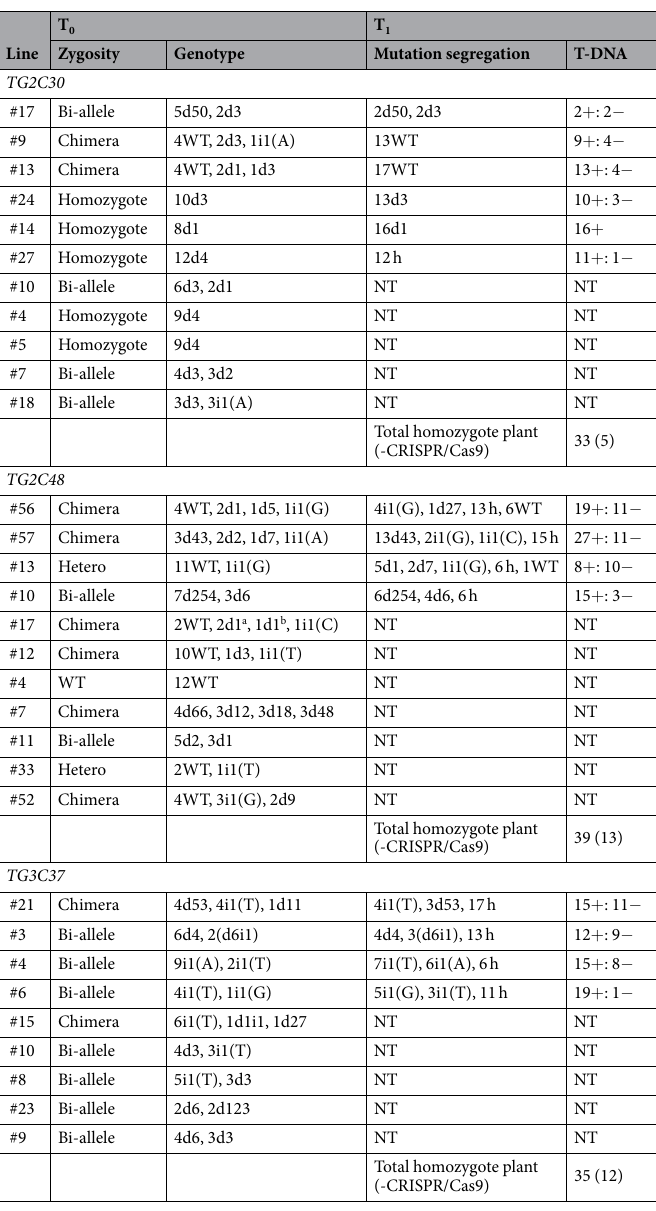
Table 1. CRISPR/Cas9-induced mutations in target genes. The zygosities, such as homozygote, bi-allele and heterozygote, were estimated on T 0 plant. WT, wild-type sequence with no mutation detected. “d” and “i” mean deletion and insertion, respectively. (A,T,G,C) after “i” indicated the inserted base pair. “il (T) means “T” was inserted on target site. In T 0 generation, “d#” or “i#” is # of base pair were deleted or were inserted on target site. Numbers before “d” or “i” mean the number of clones we checked. “d1i1” means 1 bp was deleted and inserted at the same time. “a” and “b” in Superscript mean different type of 1 base pair deletion. In T 1 generation, numbers before “d” or “i” means plant number with mutation in each lines. All “d” and “i” are homozygous. “h” is heterozygous. “NT” means not-tested. “ + ” and “ − ” are with or without T-DNA insertion. The number before “ + ” or “ − ” is plant